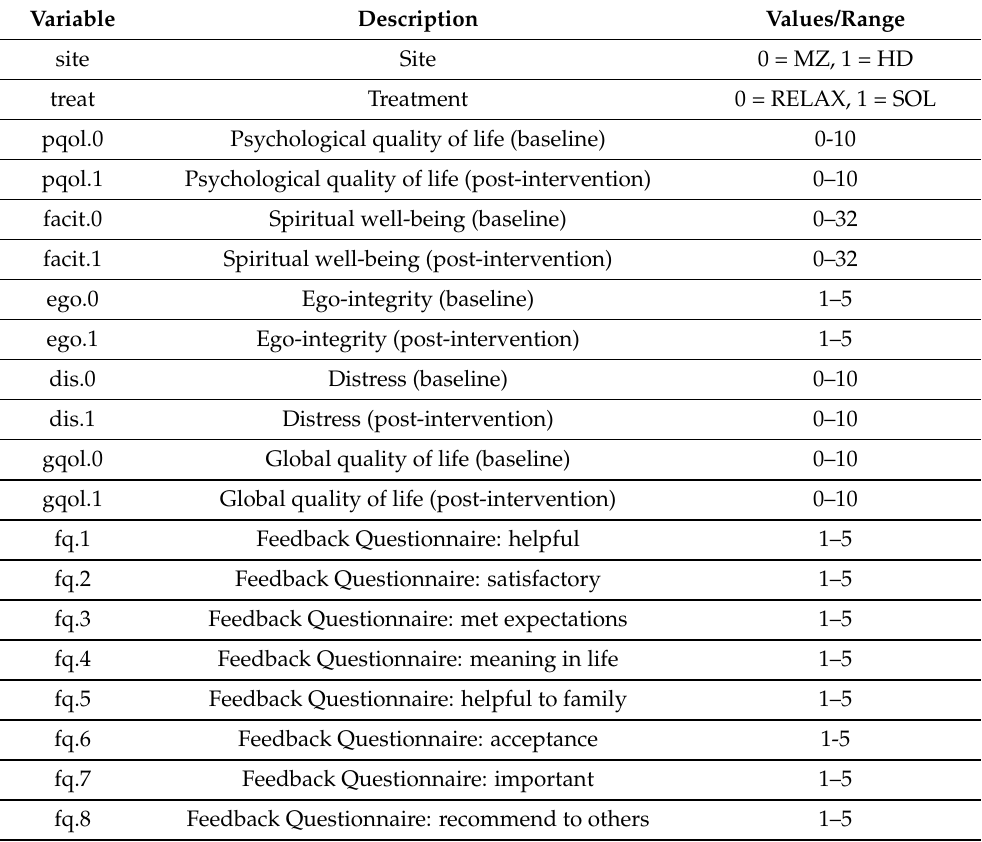
Table 1. The definitions and symbols of the